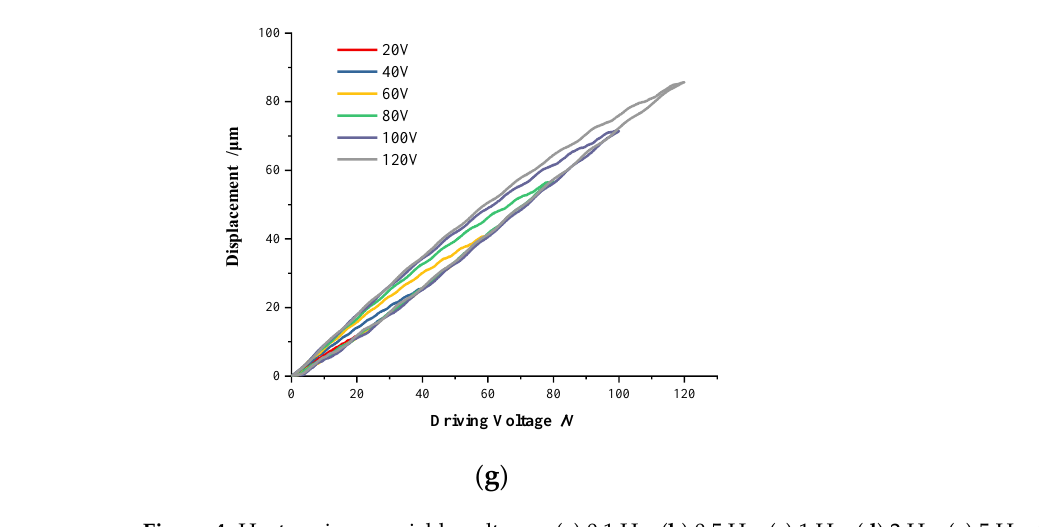
Figure 4. Hysteresis on variable voltages. ( a ) 0.1 Hz; ( b ) 0.5 Hz; ( c ) 1 Hz; ( d ) 2 Hz; ( e ) 5 Hz; ( f ) 10 Hz; ( g ) 20 Hz.